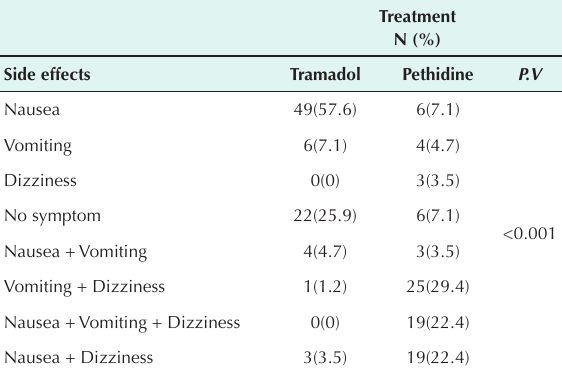
Table 3. Relationship between side effect and